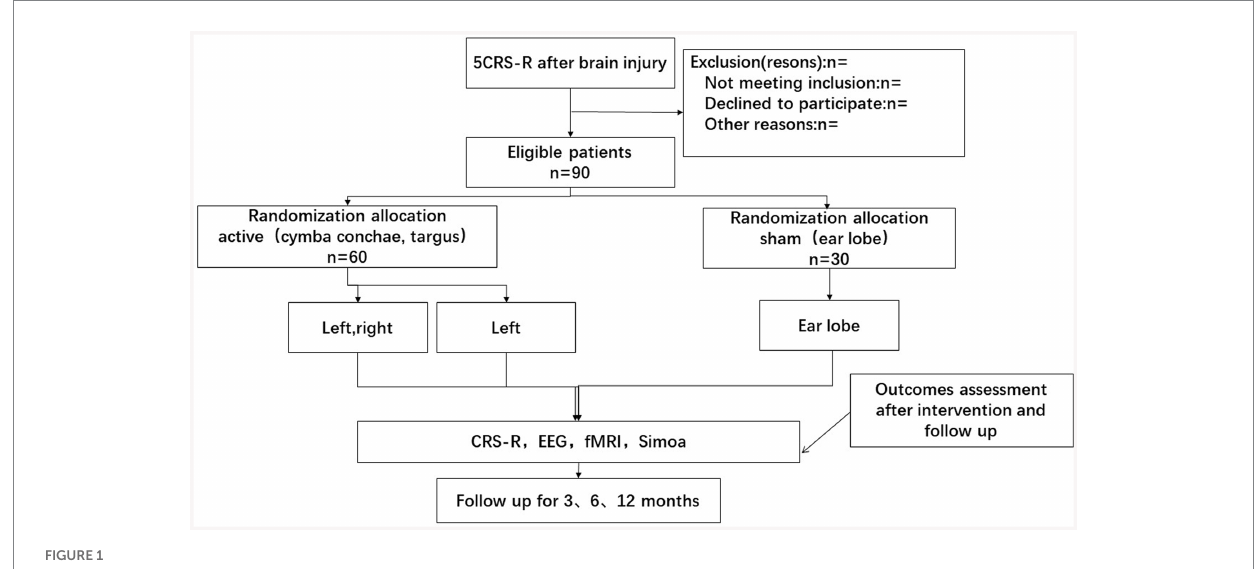
FIGURE 1 Flowchart of the